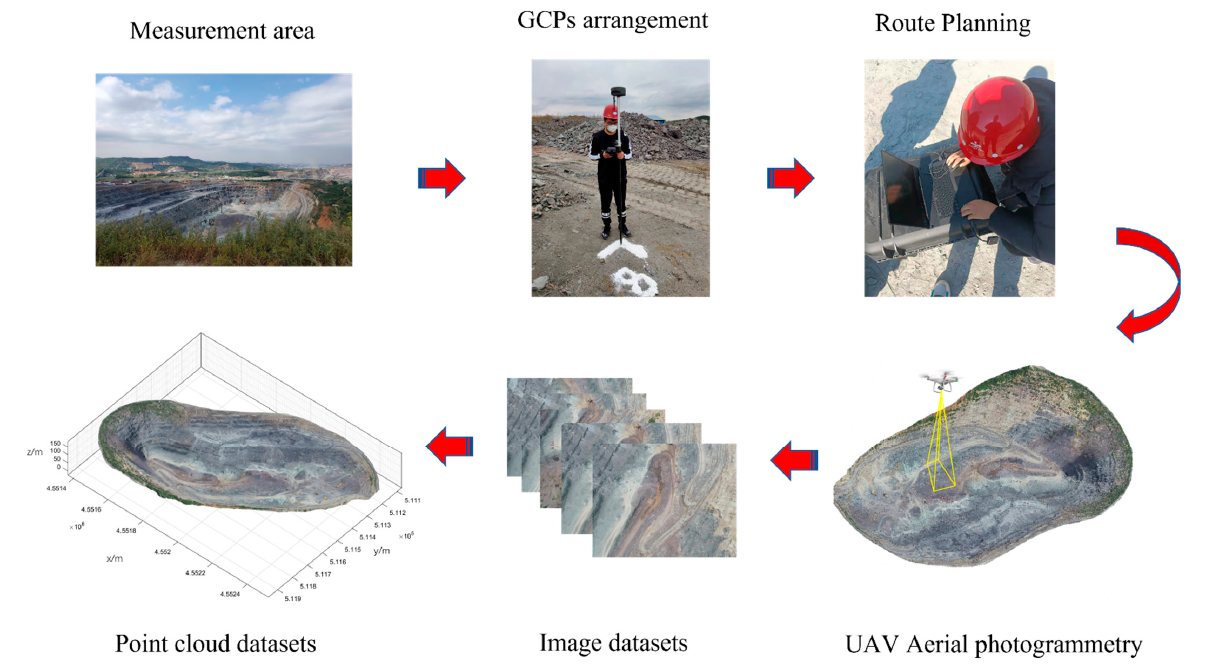
Figure 4. The above six diagrams show the six important steps of the point-cloud-data acquisition process and the sequence, each with a corresponding name for labeling.